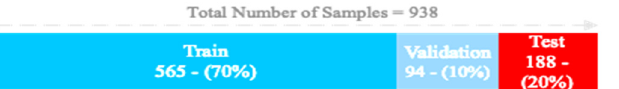
Figure 6. The allocation of the samples for the training, validation, and test dataset.